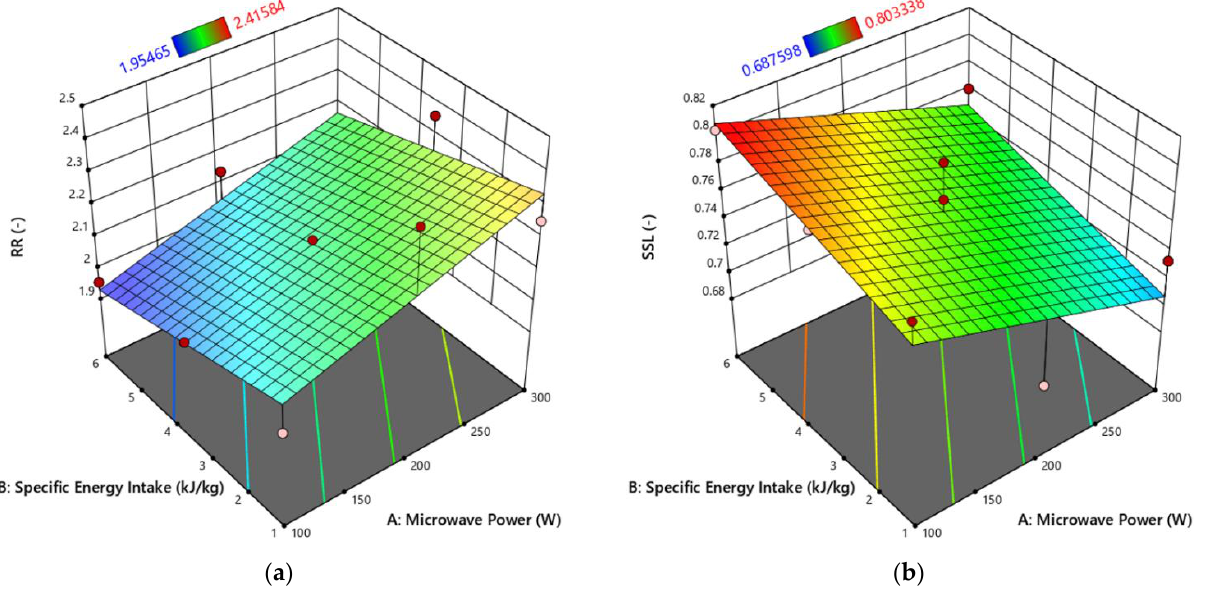
Figure 4. Response surfaces of: ( a ) rehydration ratio (RR); ( b ) relative dry matter content (SSL) in apples treated with PEF prior to microwave-convective drying, depending on the microwave power (factor A) and specific energy intake (factor B).